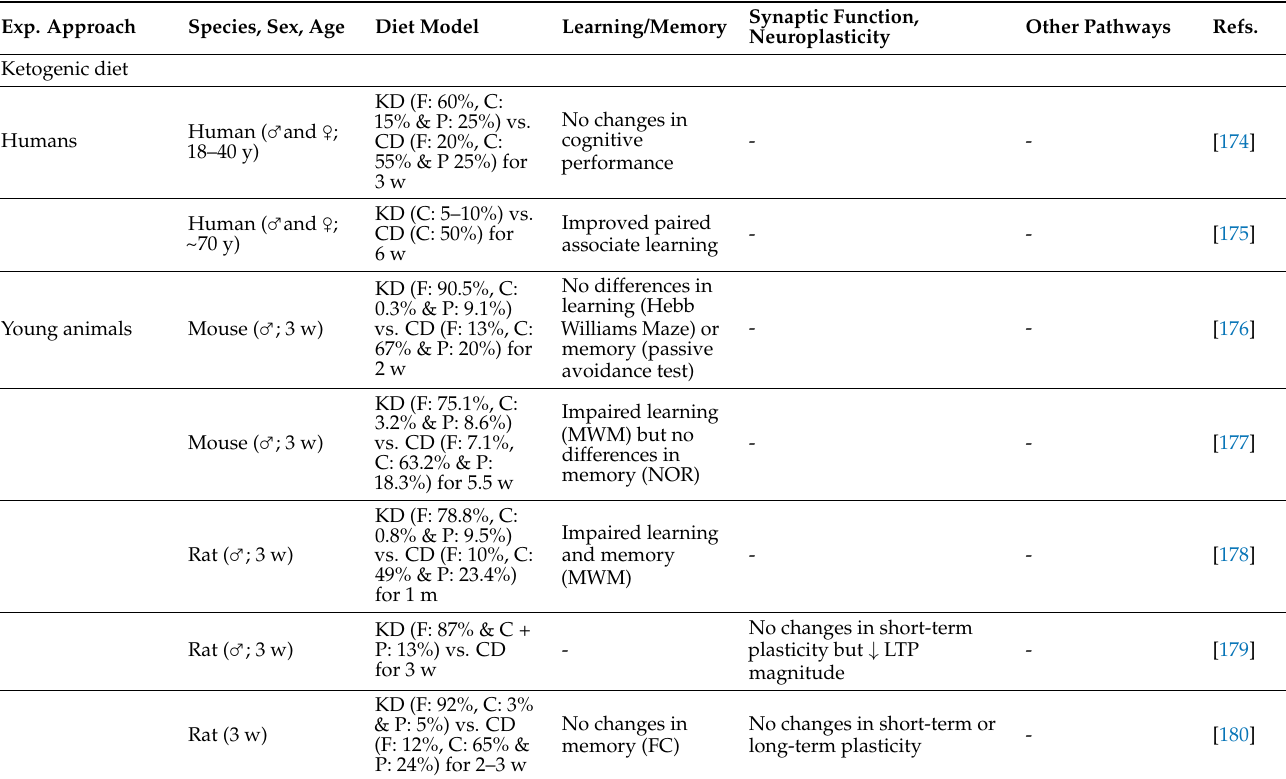
Table 4. KD and KB supplementation effects on synaptic function and cognition in humans and animals. Synaptic Function, Learning/Memory Neuroplasticity Other